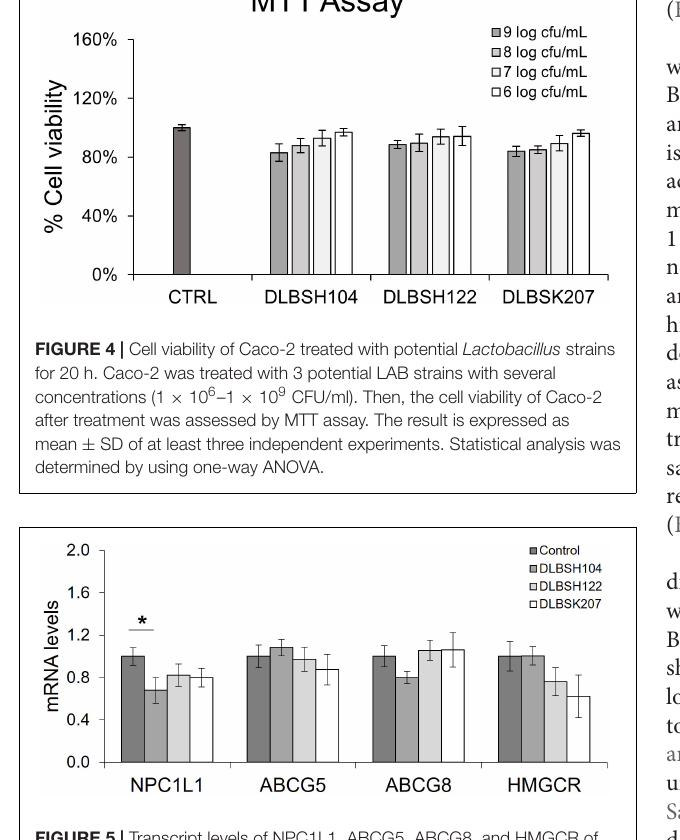
FIGURE 5 | Transcript levels of NPC1L1, ABCG5, ABCG8, and HMGCR of Caco-2 treated with cholesterol (70 µ g/L) and potential Lactobacillus strains (10 7 CFU/ml). mRNA levels of several cholesterol homeostasis genes were measured after cholesterol and LAB treatment at 37 ◦ C for 20 h. The result is expressed as mean ± SD of at least three independent experiments. Student’s t -test was used and * represents a significant difference with a p -value < 0.05 compared to the